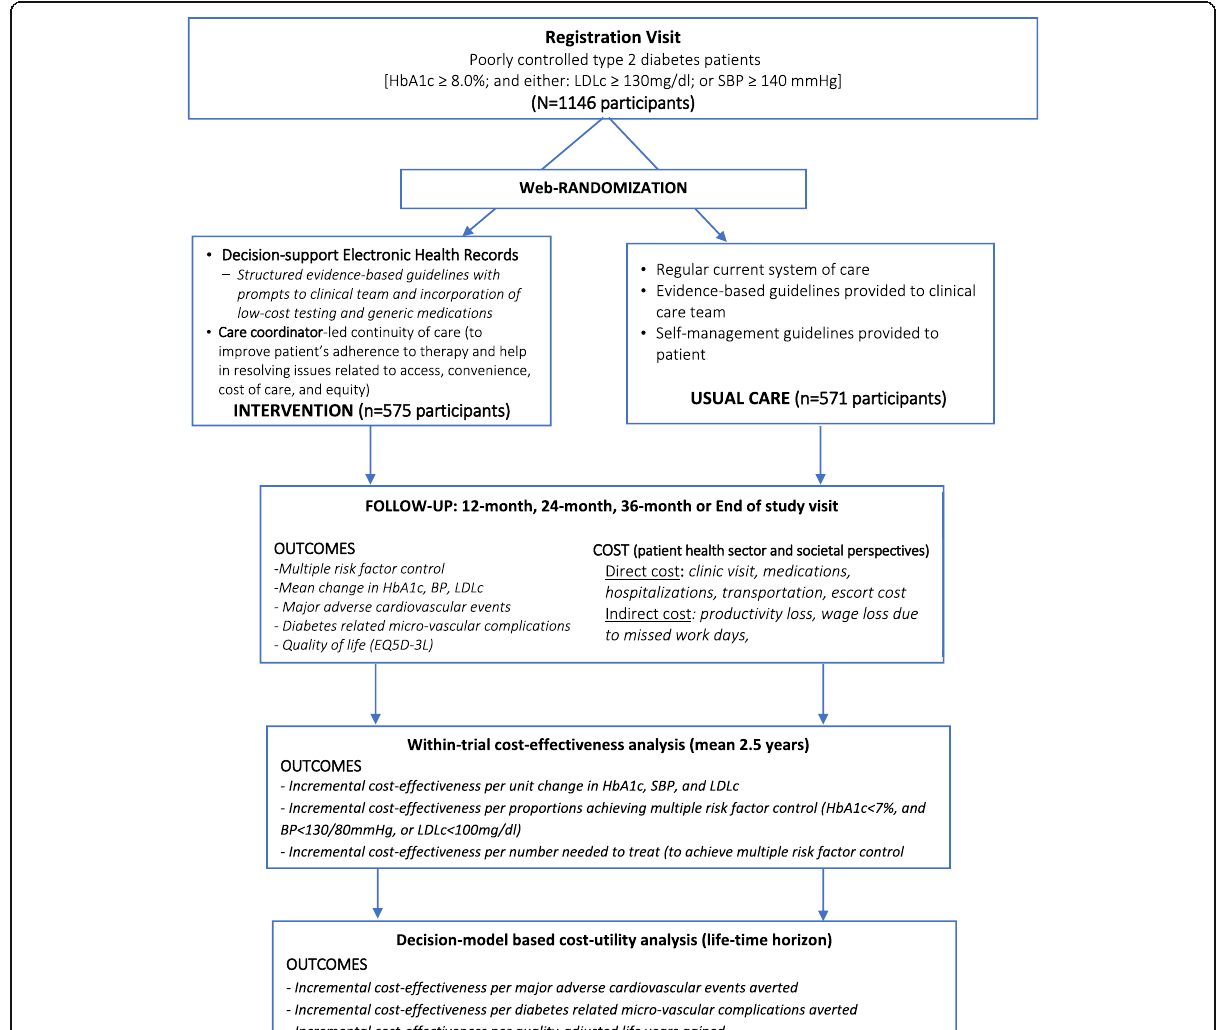
Fig. 1 Study flow - Economic evaluation alongside CARRS Trial. Abbreviations: CARRS=Centre for Cardiometabolic Risk Reduction in South Asia), DS-EHR = decision-support electronic health records; HbA1c = glycated hemoglobin, BP = blood pressure, SBP = systolic blood pressure, LDLc = low-density lipoprotein cholesterol, EQ5D-3 L = European quality of life 5 dimension 3 levels; mg/dl = milligrams per deciliter, mmHg = millimeter of